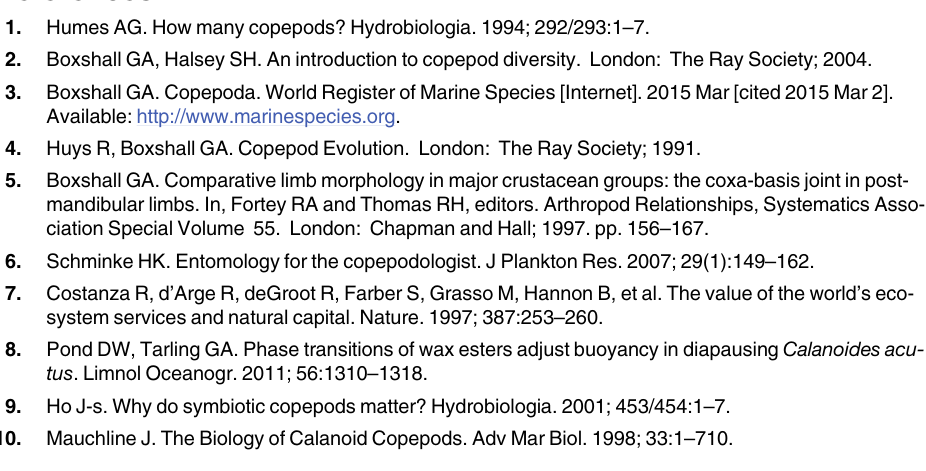
S7 Table. Mean genetic distances within each species estimated from COI nucleotide sequences of 12 harpacticoid species (N = 14) based on Kimura-2-parameter distances. S8 Table. Kimura-2-parameter pairwise distances between species estimated from COI nucleotide sequences of 12 harpacticoid species. S9 Table. Mean genetic distances within each species estimated from COI nucleotide sequences of 29 poecilostomatoid species (N = 33) based on Kimura-2-parameter distances. S10 Table. Kimura-2-parameter pairwise distances between species estimated from COI nucleotide sequences of 29 poecilostomatoid species. S11 Table. Mean genetic distances within each species estimated from COI nucleotide sequences of 11 siphonostomatoid species (N = 16) based on Kimura-2-parameter dis- tances. S12 Table. Kimura-2-parameter pairwise distances between species estimated from COI nucleotide sequences of 11 siphonostomatoid